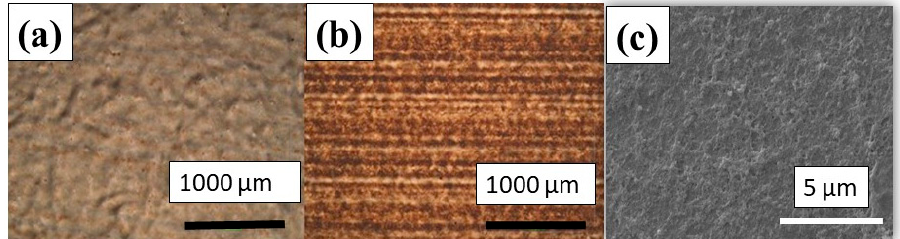
Figure 6. Optical micrograph of the inkjet printed PEDOT:PSS pattern after ( a ) two passes and ( b ) five passes. ( c ) SEM image of 5 passes of PEDOT:PSS ink pattern .